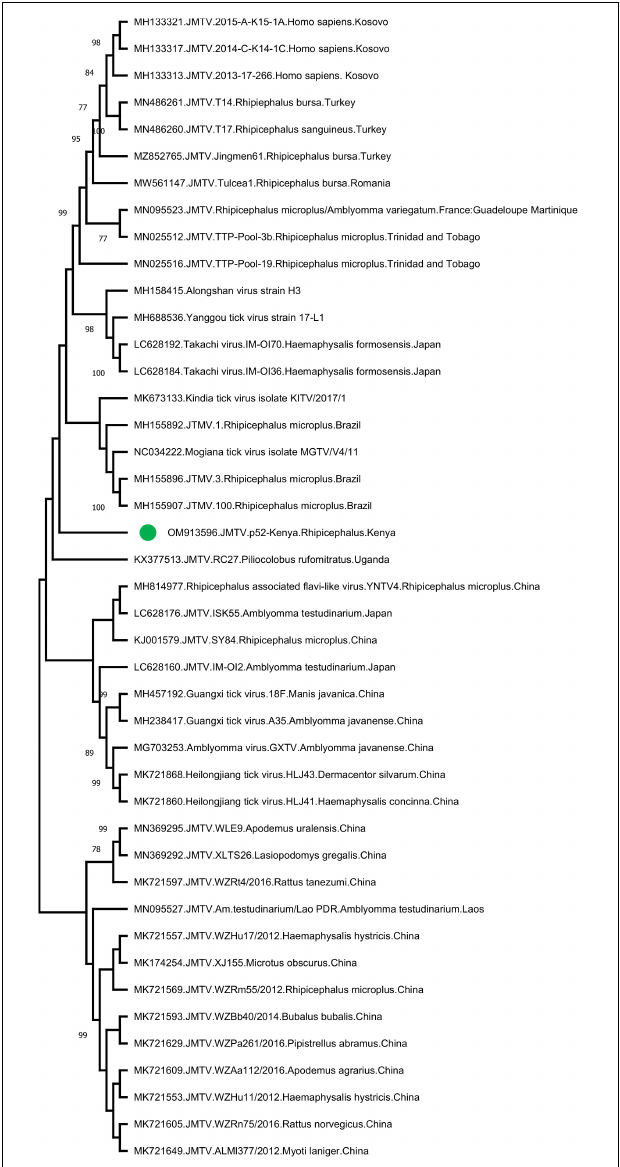
FIGURE 3 | The maximum likelihood analysis of the Jingmen tick virus (JMTV) partial segment 1 sequences (366 nucleotides). The tree is constructed using a gamma-distributed Kimura 2-parameter model for 500 replications. JMTVs included in the analysis are indicated by GenBank accession number, name, isolate/strain identifier, host, and detection region. JMTV sequence characterized in this study is marked. Bootstrap values greater than 75 are